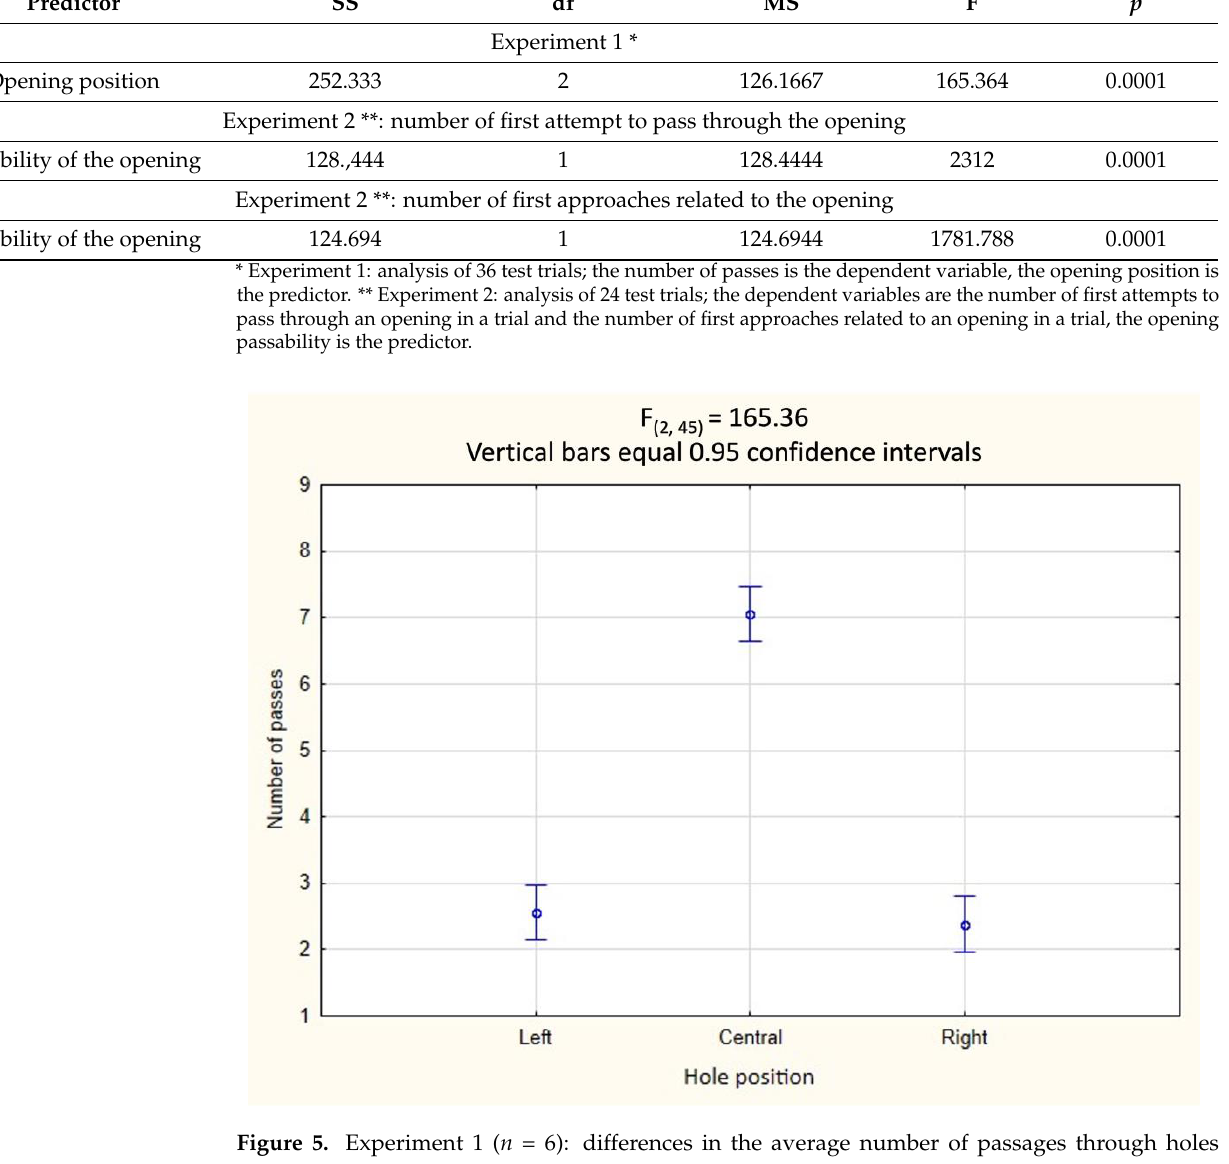
Table 1. Correlations between the predictors and dependent variables revealed by factorial ANOVA (significant only).